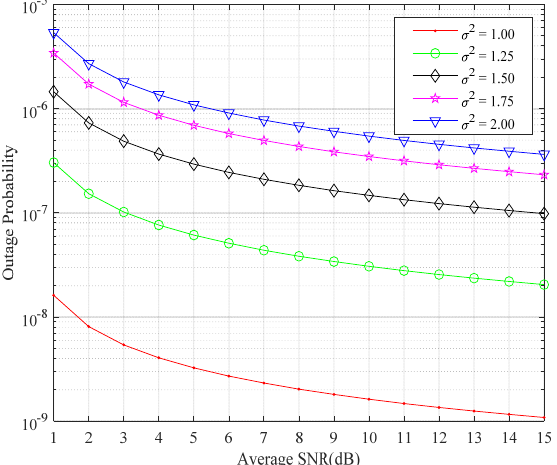
Figure 6. Outage probability of cooperative FSO communication system under different turbulence